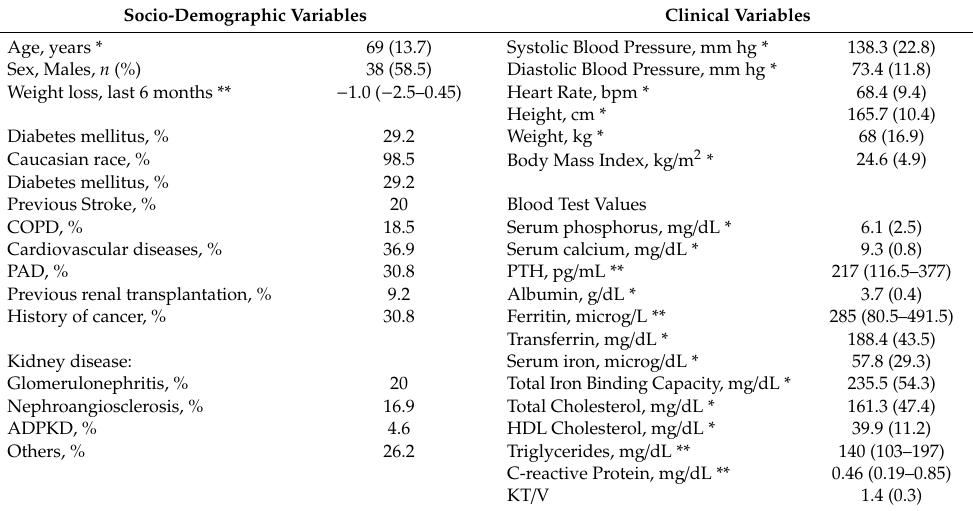
Table 1. Demographic, and clinical data of hemodialysis